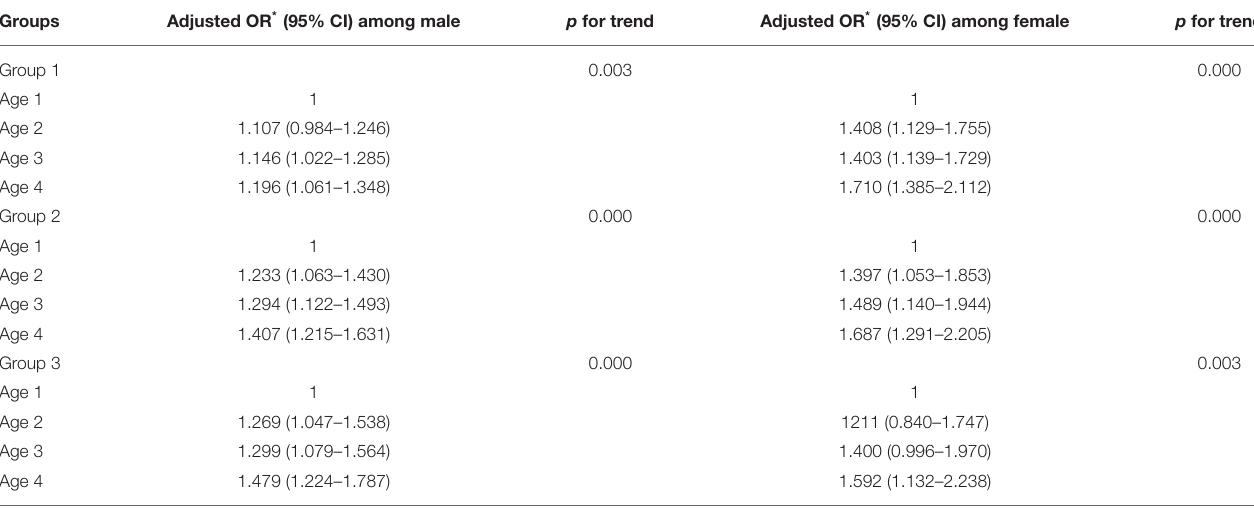
TABLE 5 | Stratified analysis by gender of association between age and diagnostic delays in human brucellosis. Groups